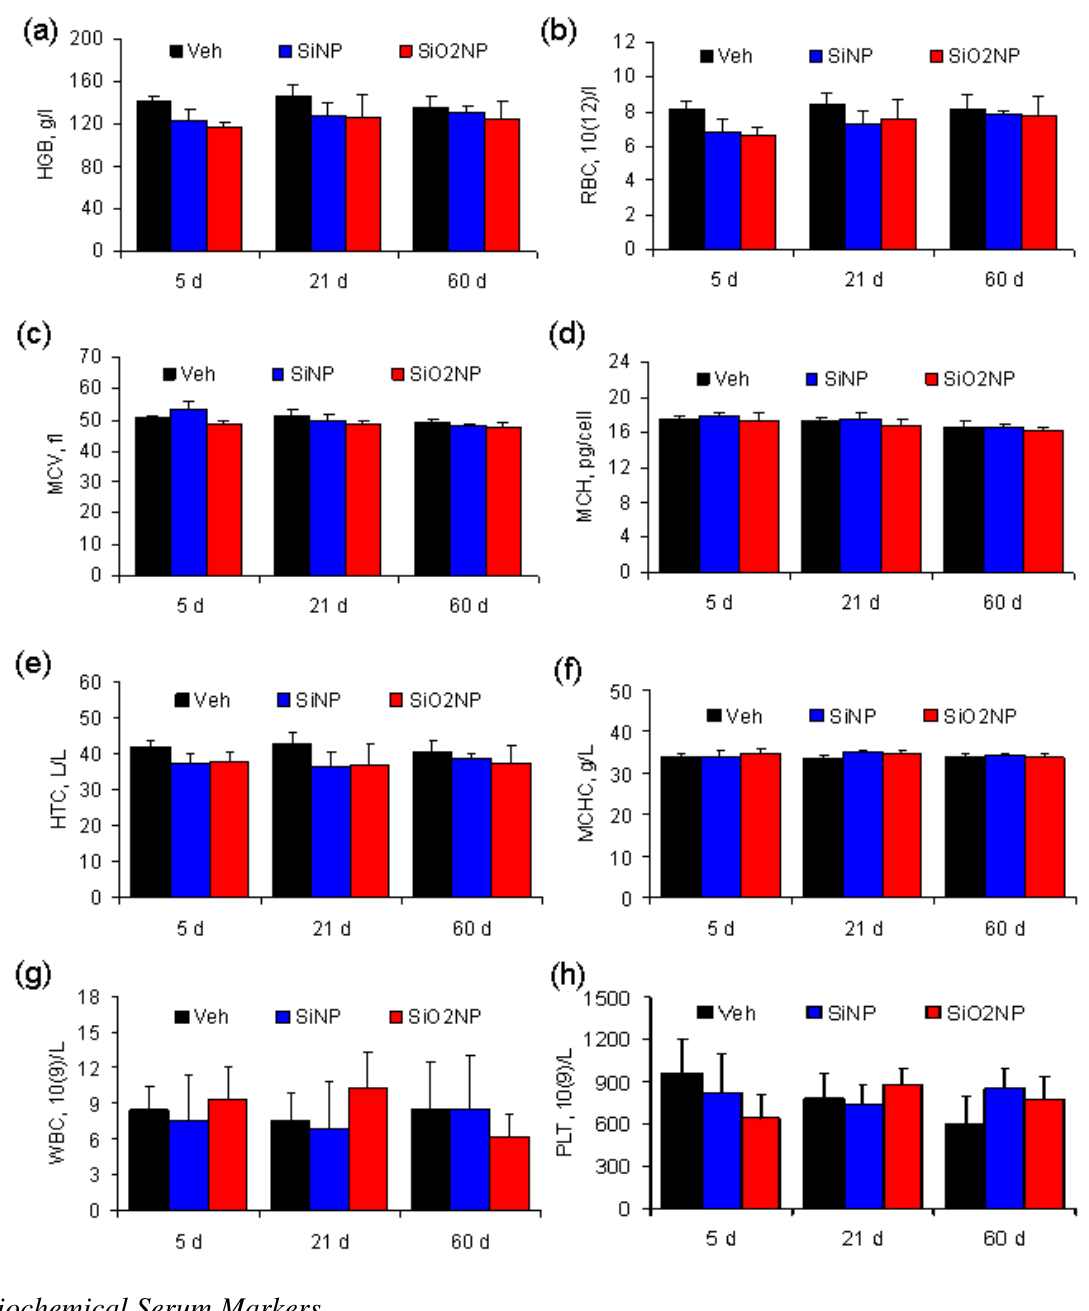
Figure 4. Blood parameters in Sprague Blood parameters in Sprague-Dawley rats treated with vehicle, SiNPs or Dawley rats treated with vehicle, SiNPs or SiO NPs at a dose of 7 mg/kg at a dose of 7 mg/kg. The results show mean values and SD of ( . The results show mean values and SD of ( a ) hemoglobin 2 (HGB); ( b ) red blood cells (RBC); red blood cells (RBC); ( c ) mean corpuscular volume (MCV); ( corpuscular volume (MCV); ( d ) mean corpuscular hemoglobin (MCH); ( corpuscular hemoglobin (MCH); ( e ) hematocrit (HCT); ( f ) mean corpuscular hemoglobin mean corpuscular hemoglobin concentration (MCHC); ( g ) white blood cells (WBC); and ( white blood cells (WBC); and ( h ) platelets (PLT). ) platelets